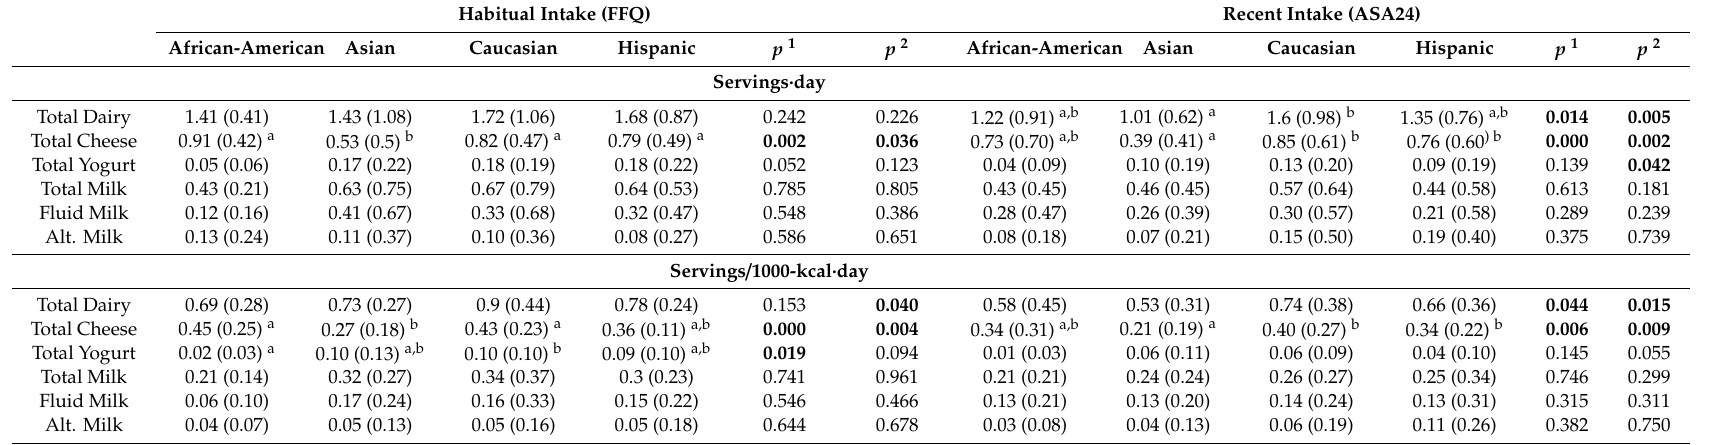
Table 4. Mean (SD) of reported servings and servings / 1000-kcal of each product for all subjects by ethnicity. Habitual Intake (FFQ) Recent Intake (ASA24) African-American Asian Caucasian Hispanic African-American Asian Caucasian